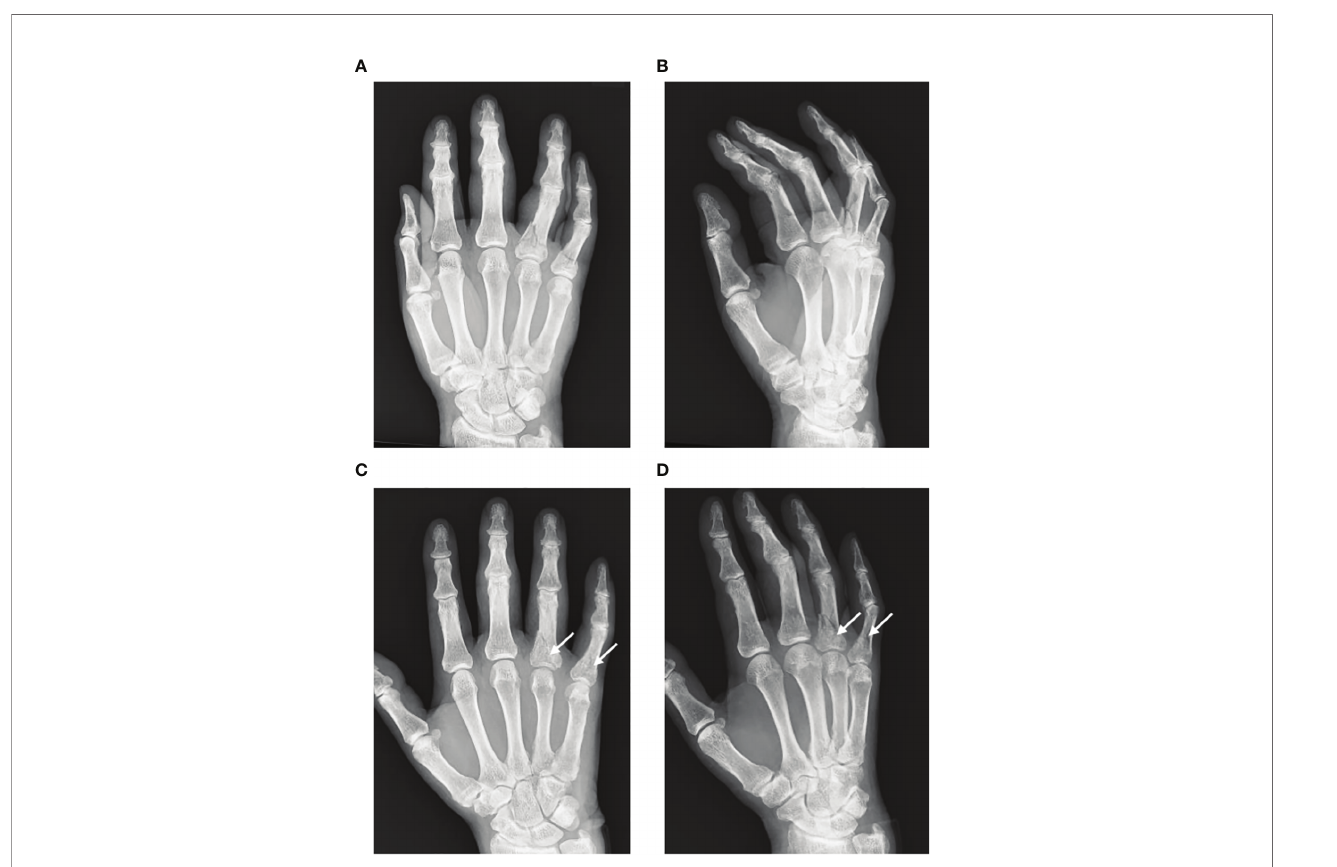
FIGURE 1 | Referential X-ray images in a patient with CRPS following phalanx fractures. The patient underwent surgical treatment for fractures of the right fourth and fi fth proximal phalanges and was diagnosed with CRPS due to persistent throbbing pain, swelling of the fi ngers, heat sensation, abnormal sweating in the palm, and a limited range of motion of the fourth and fi fth fi ngers. (A, B) Radiographic images at the time of the injury. (C, D) Radiographic images at 5 months postoperatively. White arrows indicate localized patchy bone atrophy, which is not commensurate with the ordinary course of fracture